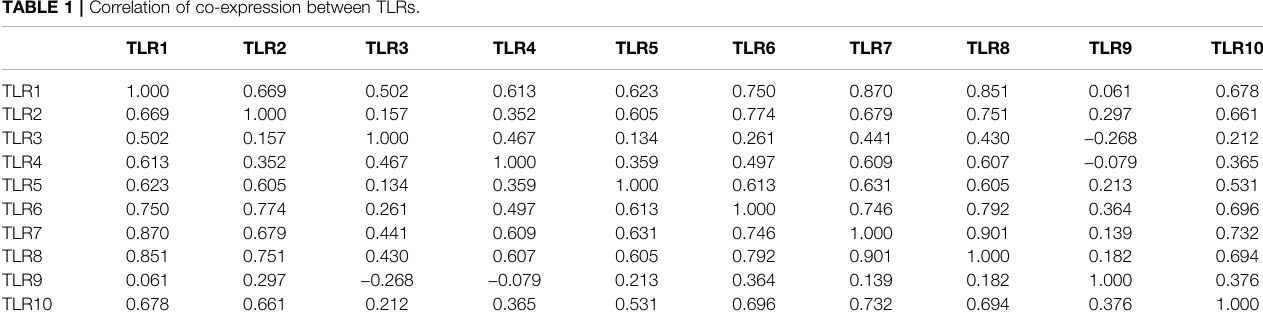
TABLE 1 | Correlation of co-expression between